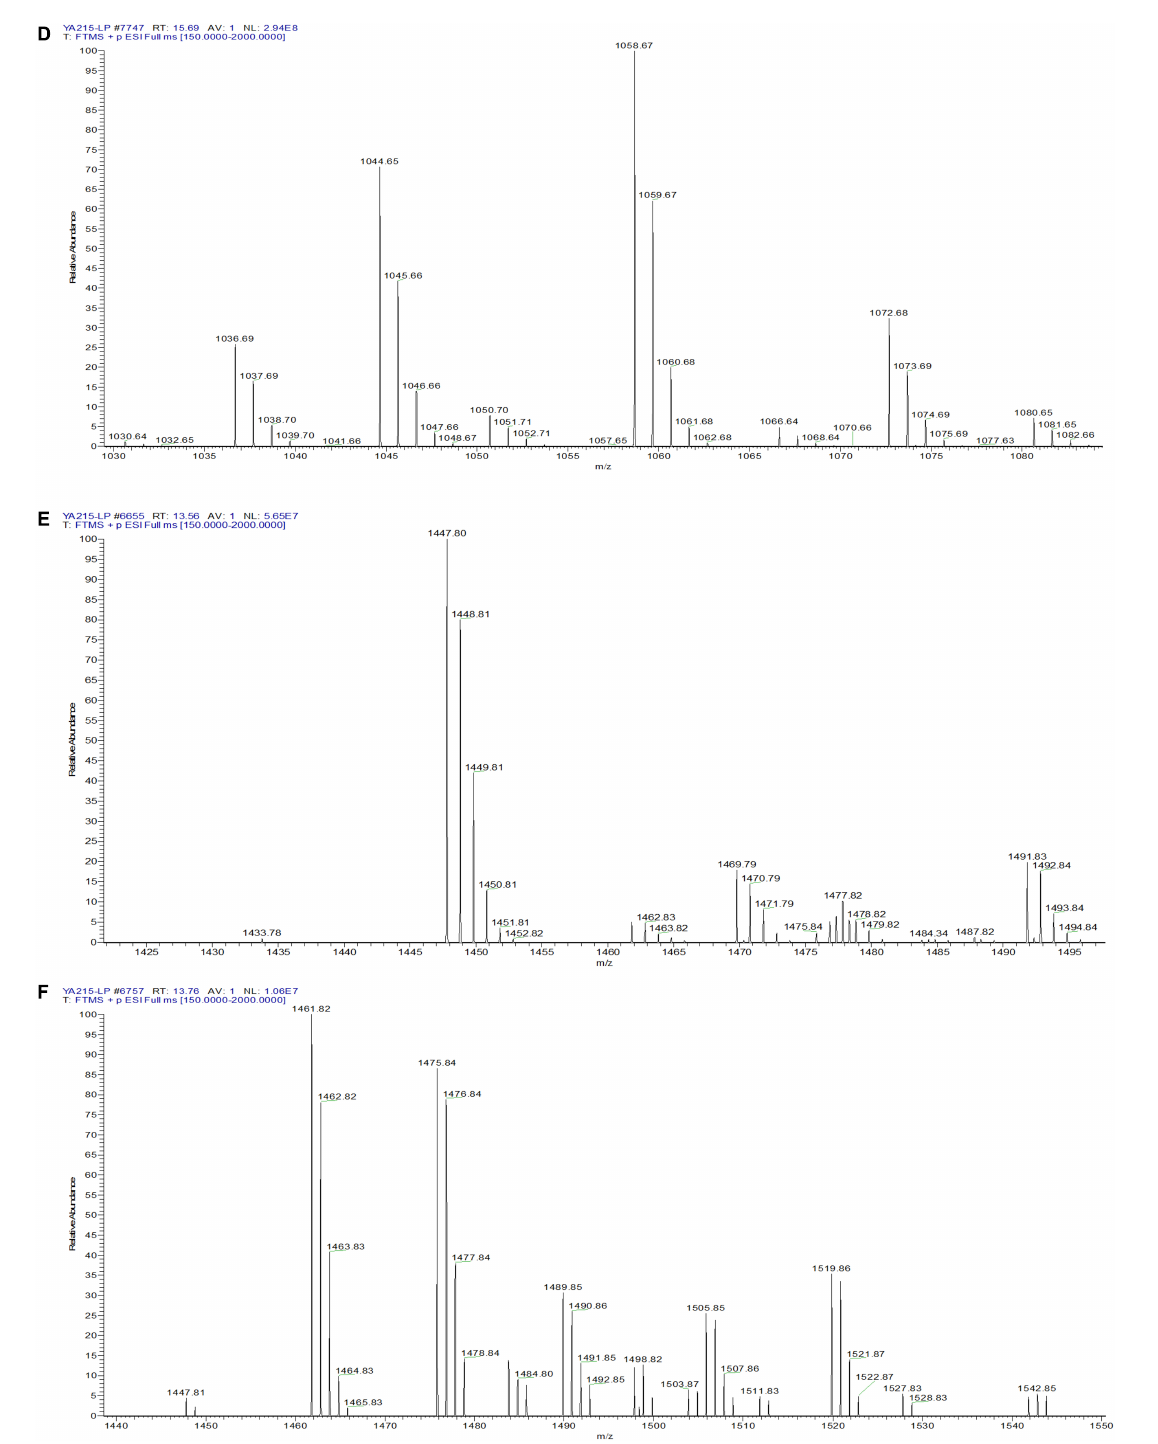
FIGURE3 LC–MS spectrum of the composition of YA215 lipopeptide extracts (YA215LE). (A) MS spectrum of the molecular ion peaks [M + H] + at 993.41, 1007.59 and 1021.57, (B) MS spectrum of the molecular ion peaks [M + H] + from 1035.46 to1099.60, (C) MS spectrum of the molecular ion peaks from 994.64 to 1022.67, (D) MS spectrum of the molecular ion peaks from 1030.64 to 1072.68, (E) MS spectrum of fengycin A analogs with the molecular ion peaks from 1449.81 to 1519.86, (F) MS spectrum of fengycin B analogs with the molecular ion peaks from 1433.78 to